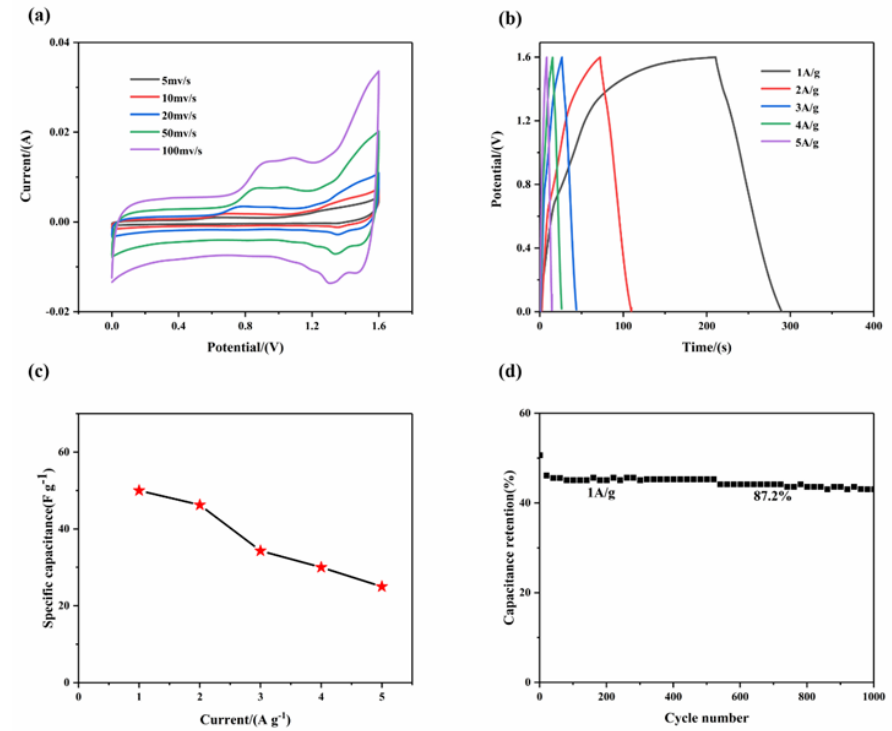
Figure 9. ( a ) Cyclic voltammetry curves at different sweep speeds; ( b ) charge–discharge curves under different current densities; ( c ) relation curve between current density and specific capac- itance; ( d ) diagram of 1000 cycles under current density of MWCNT 3 @Co 3 O 4 //AC asymmetric supercapacitor (1 A · g − 1 ).